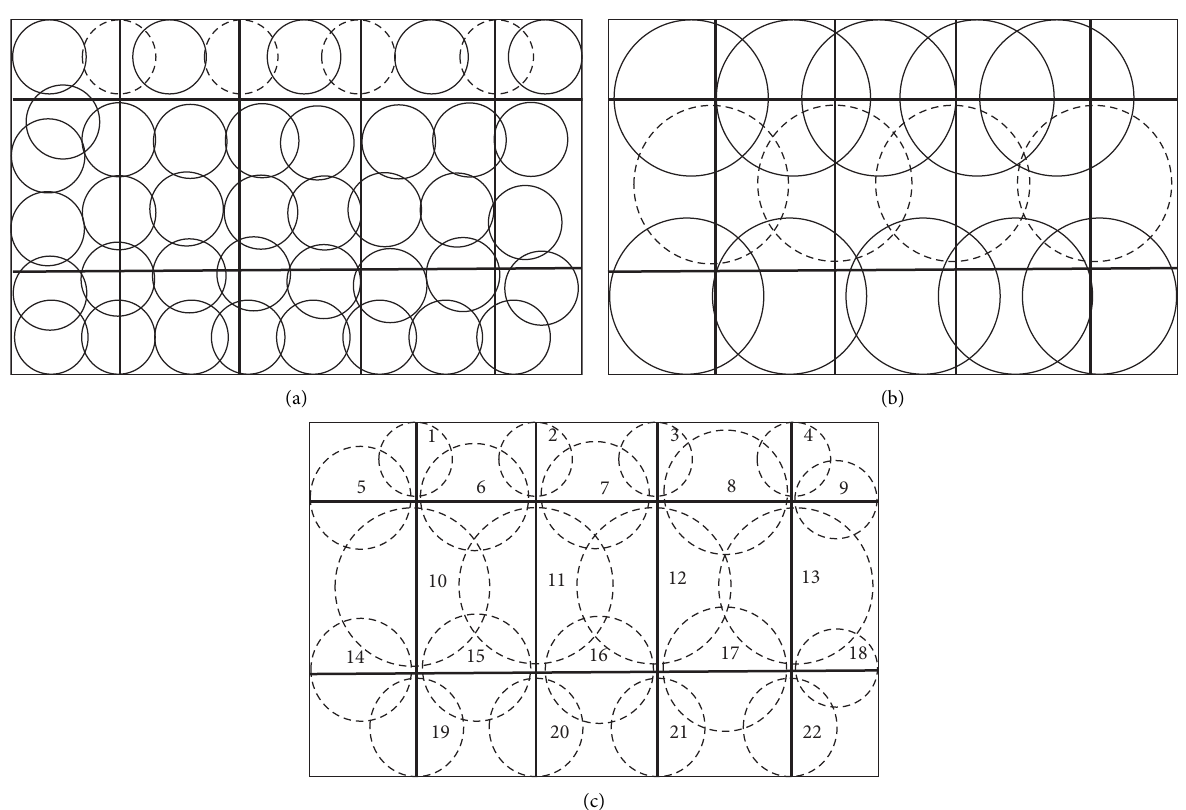
Figure 3: An illustration of Algorithm 1. (a) Focus area with r � r